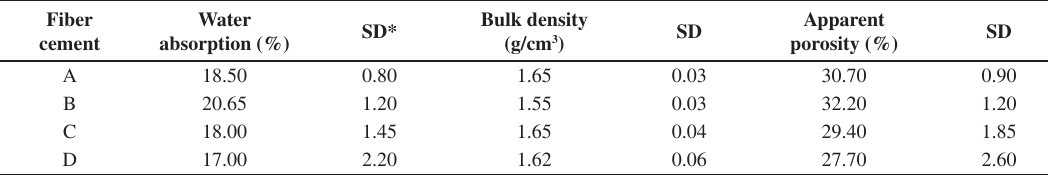
Table 12. Physical characteristics after soak & dry cycles.